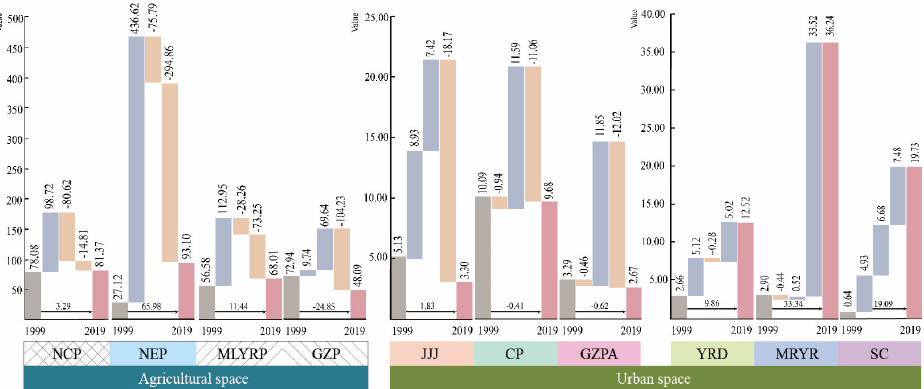
Figure 8. Sensitivity response of carbon emission intensity to changes in space utilization efficiency.